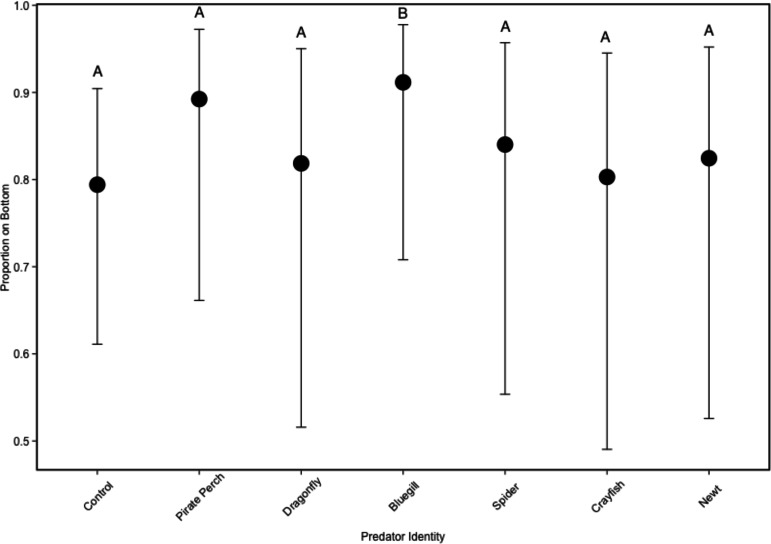
Tadpole spatial positioning patterns with different predators.The model-generated mean spatial position of Lithobates sphenocephalus tadpoles in the non-lethal predator treatments with 95% confidence intervals (\documentclass[12pt]{minimal}
\usepackage{amsmath}
\usepackage{wasysym}
\usepackage{amsfonts}
\usepackage{amssymb}
\usepackage{amsbsy}
\usepackage{upgreek}
\usepackage{mathrsfs}
\setlength{\oddsidemargin}{-69pt}
\begin{document}
}{}${\chi }_{6}^{2}=18.44$\end{document}χ62=18.44, P < 0.005). Treatments that share the same letter are not significantly different from the control, as determined by false discovery rate corrected post hoc analysis.